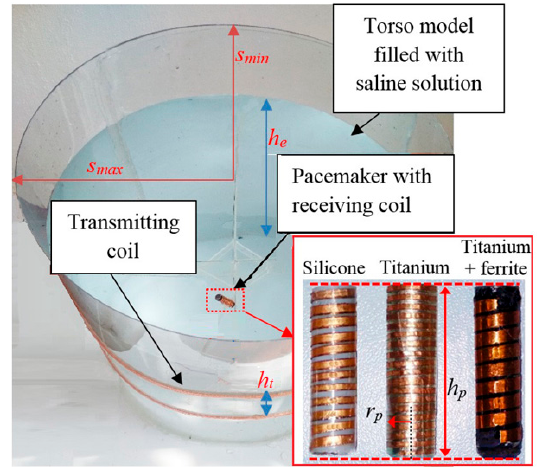
Figure 17. Sketch of the measurement setup with details of the three devices. Table 3. Calculated and measured secondary circuit parameters.